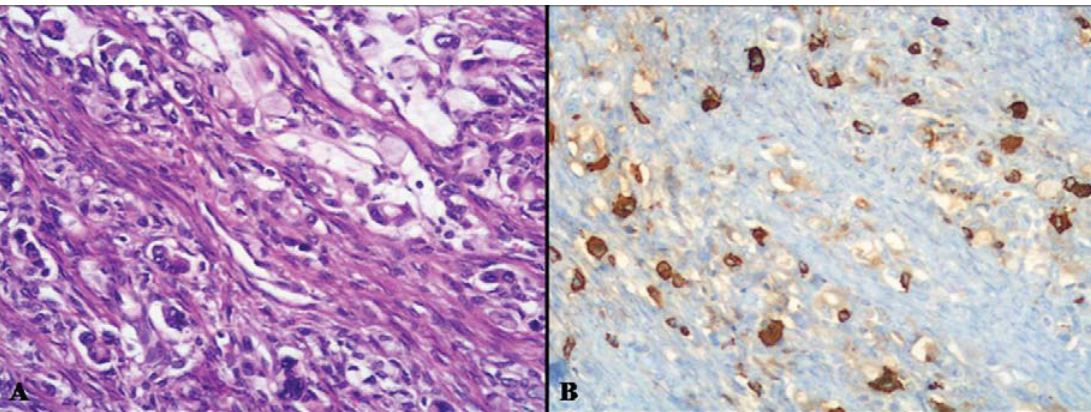
Figure 10. Mixed poorly cohesive carcinoma-NET is a combined neoplasm composed of noncohesive signet ring cells diffusely admixed with neuroendocrine cells ( A ), which are easily detectable using chromogranin A antibody ( B